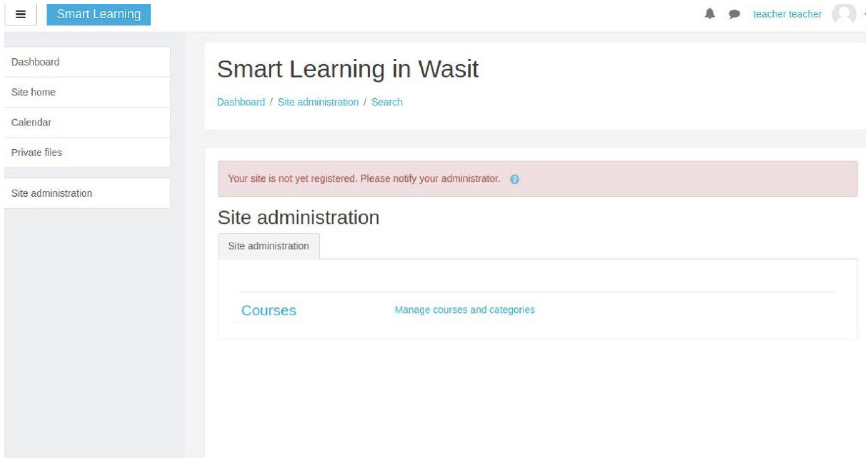
Fig. 3. Teacher’s